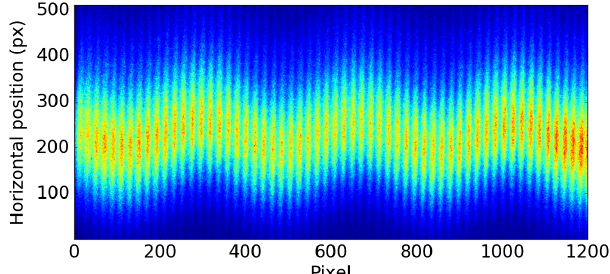
FIG. 1. Raw image taken by the fast-gated intensified camera (FGC). It shows 58 projections of the same bunch for every 14th turn. The optical path of the setup rotates the spots by 90° so their horizontal axis is displayed on the vertical axis of the image.